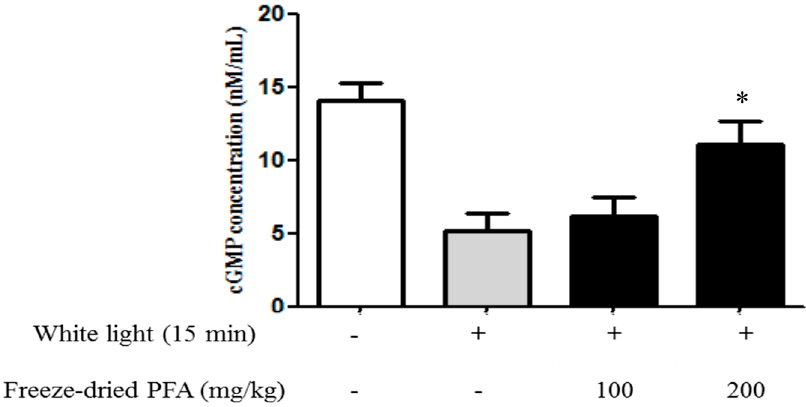
Figure 6. Effect of freeze-dried Perilla frutescens var. acuta (PFA) on cGMP contents in rat whole eye. Freeze-dried PFA was administered at 100 mg/kg and 200 mg/kg doses for three days before irradiation with white light for 15 min. Intracellular cGMP levels were measured by ELISA. The data are represented as mean ± SD ( n = 5). * p < 0.05 compared with the control.